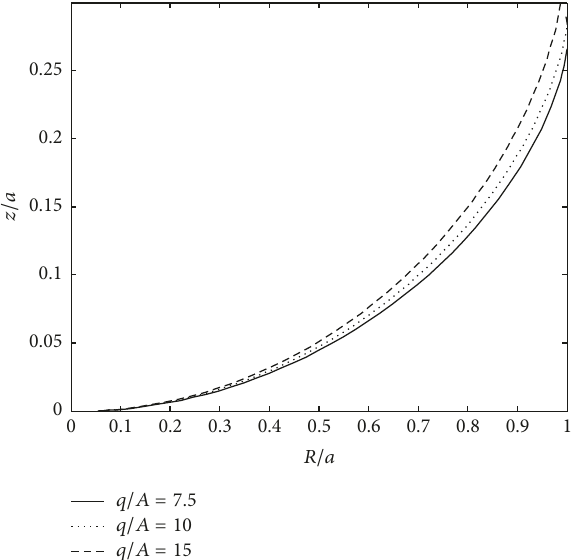
Figure 4: The vertical displacement curve of membrane ( 𝑛 = 2 ; 𝛼 = 1 ).